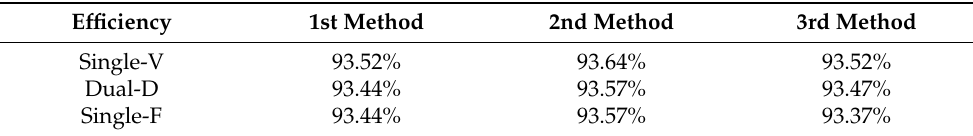
Table 3. Efficiency comparison of three different rotor structure at 6540 rpm, 24 A phase current based on three different type of iron loss.